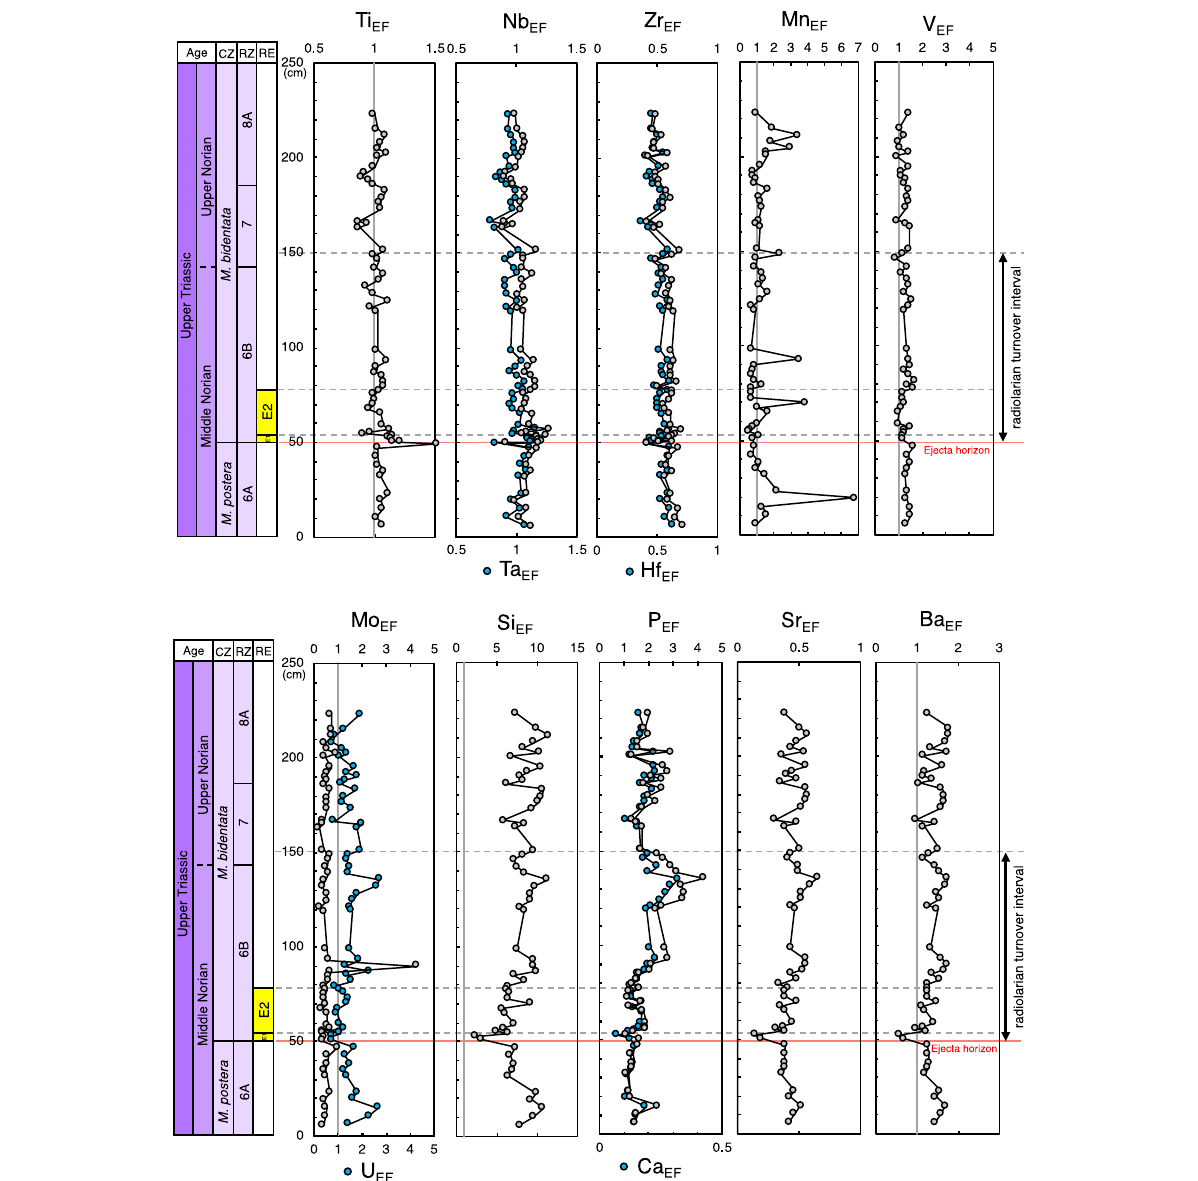
Fig. 7 Stratigraphic profiles of major and trace elements in the studied section. Enrichment factors (EF) were calculated relative to UCC (Rudnick and Gao 2014). Gray lines indicate UCC values. Data for non-detrital elements in SiO 2 -poor parts of the claystone samples (NH52-R2, -R3, -R5, and -R7) are excluded from the stratigraphic